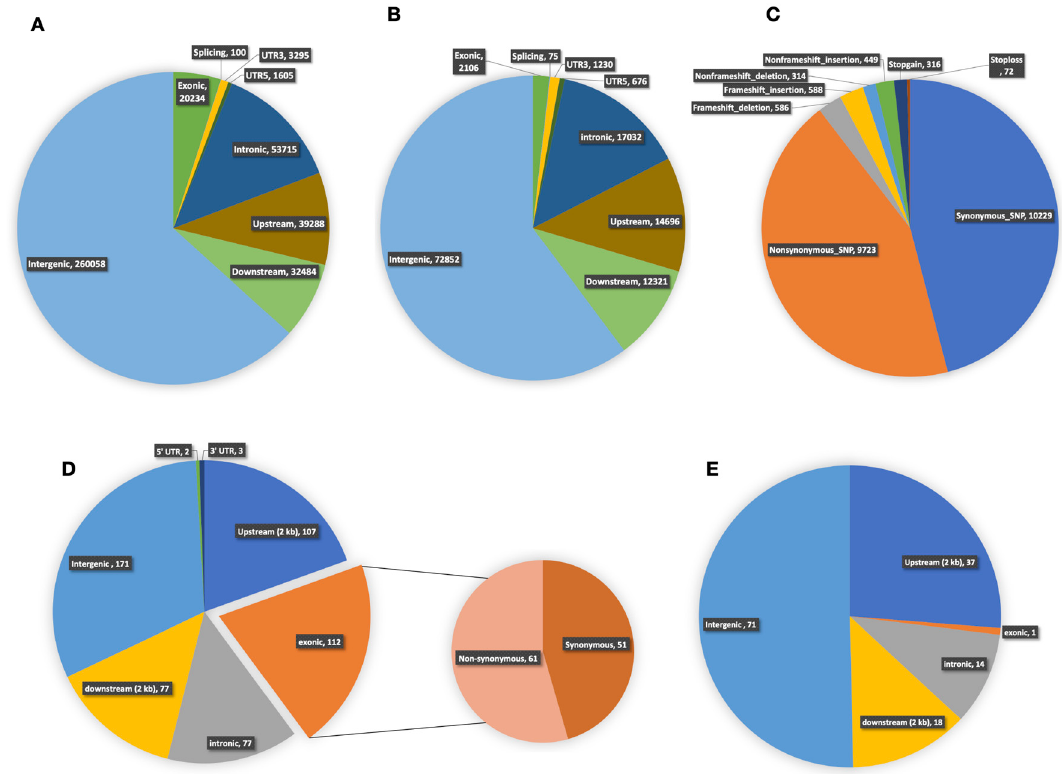
Figure 7. Annotation and distribution of single-nucleotide polymorphisms (SNPs) and insertions and deletions (InDels). Distribution of ( A ) SNPs; and ( B ) InDels in di ff erent genomic regions. ( C ) Annotation of total large-e ff ect SNPs and InDels in di ff erent genic regions. Distribution of ( D ) SNPs; and ( E ) InDels in di ff erent intergenic and genic regions of chitinase genes from C. sativus lines 3229 vs 3461. The number of synonymous and non-synonymous SNPs detected within the CDS region has also been shown. Distribution of SNPs and InDels were 3229 vs